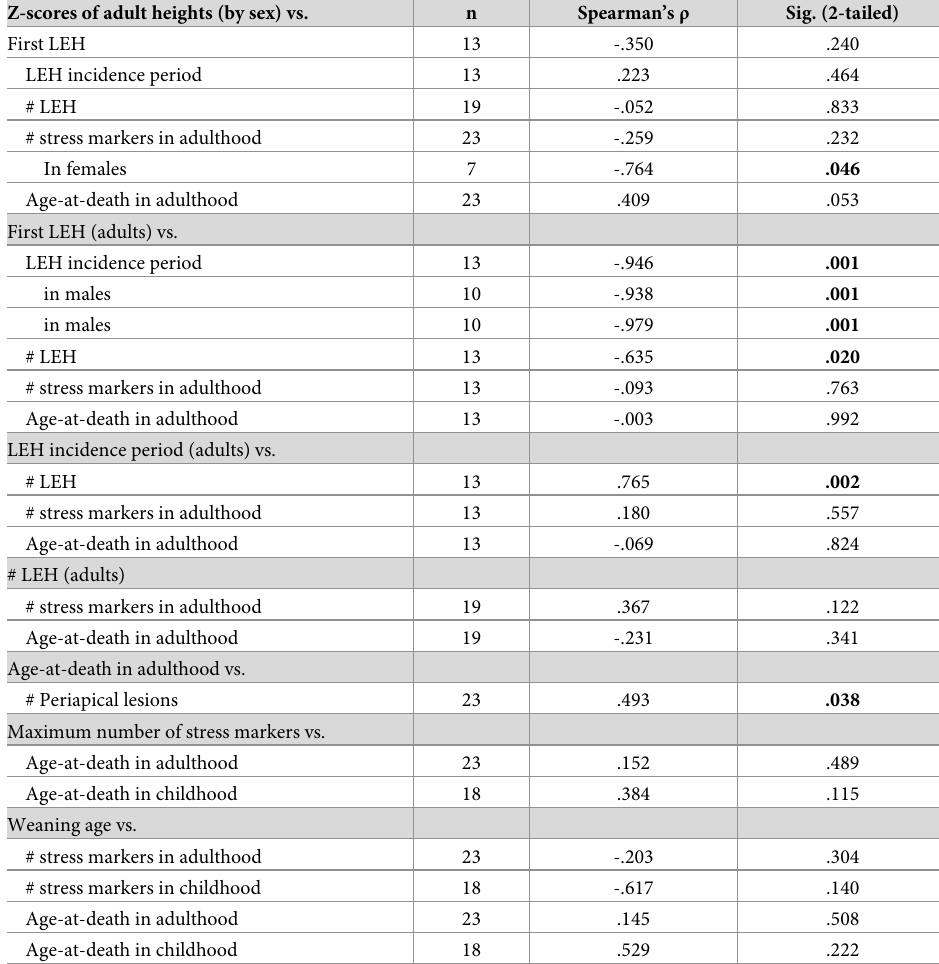
Table 4. Correlations between variables in adults from Jabuticabeira II (females and males pooled). Z-scores of adult heights (by sex)